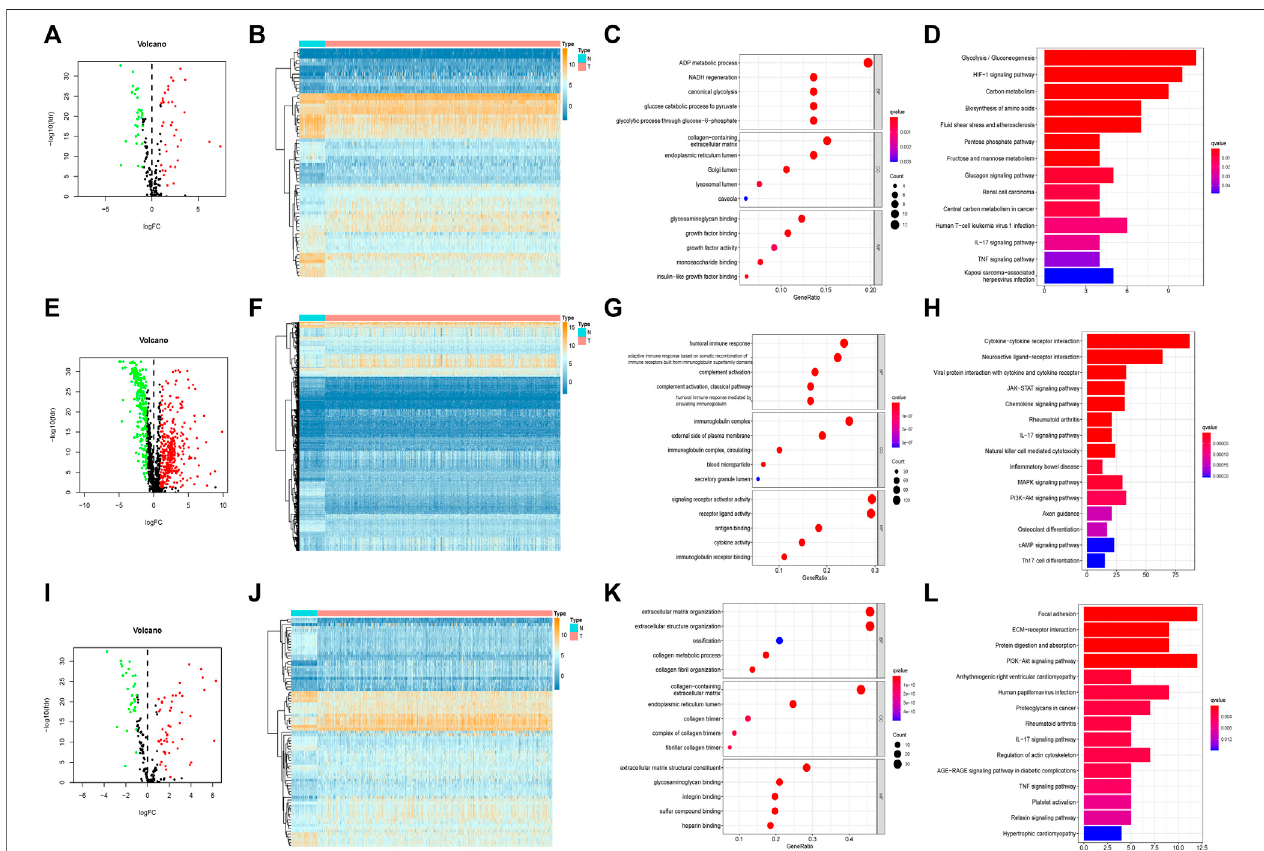
FIGURE2| Separativelly screening ofdifferentially expressed hypoxia, immunity and EMTrelated genes. (A) Volcano plots showing thehypoxia-related DEGs. (B) Heatmaps of differentially expressed hypoxia-related mRNAs. (C) GO enrichment of hypoxia-related DEGs. (D) KEGG pathways of hypoxia-related DEGs. (E) Volcano plots showing the immune-related DEGs. (F) Heatmaps of differentially expressed immune-related mRNAs. (G) GO enrichment of immune-related DEGs. (H) KEGG pathways of immune-related DEGs. (I) Volcano plots showing the EMT-related DEGs. (J) Heatmaps of differentially expressed EMT-related mRNAs. (K) GO enrichment of EMT-related DEGs. (L) KEGG pathways of EMT-related DEGs.